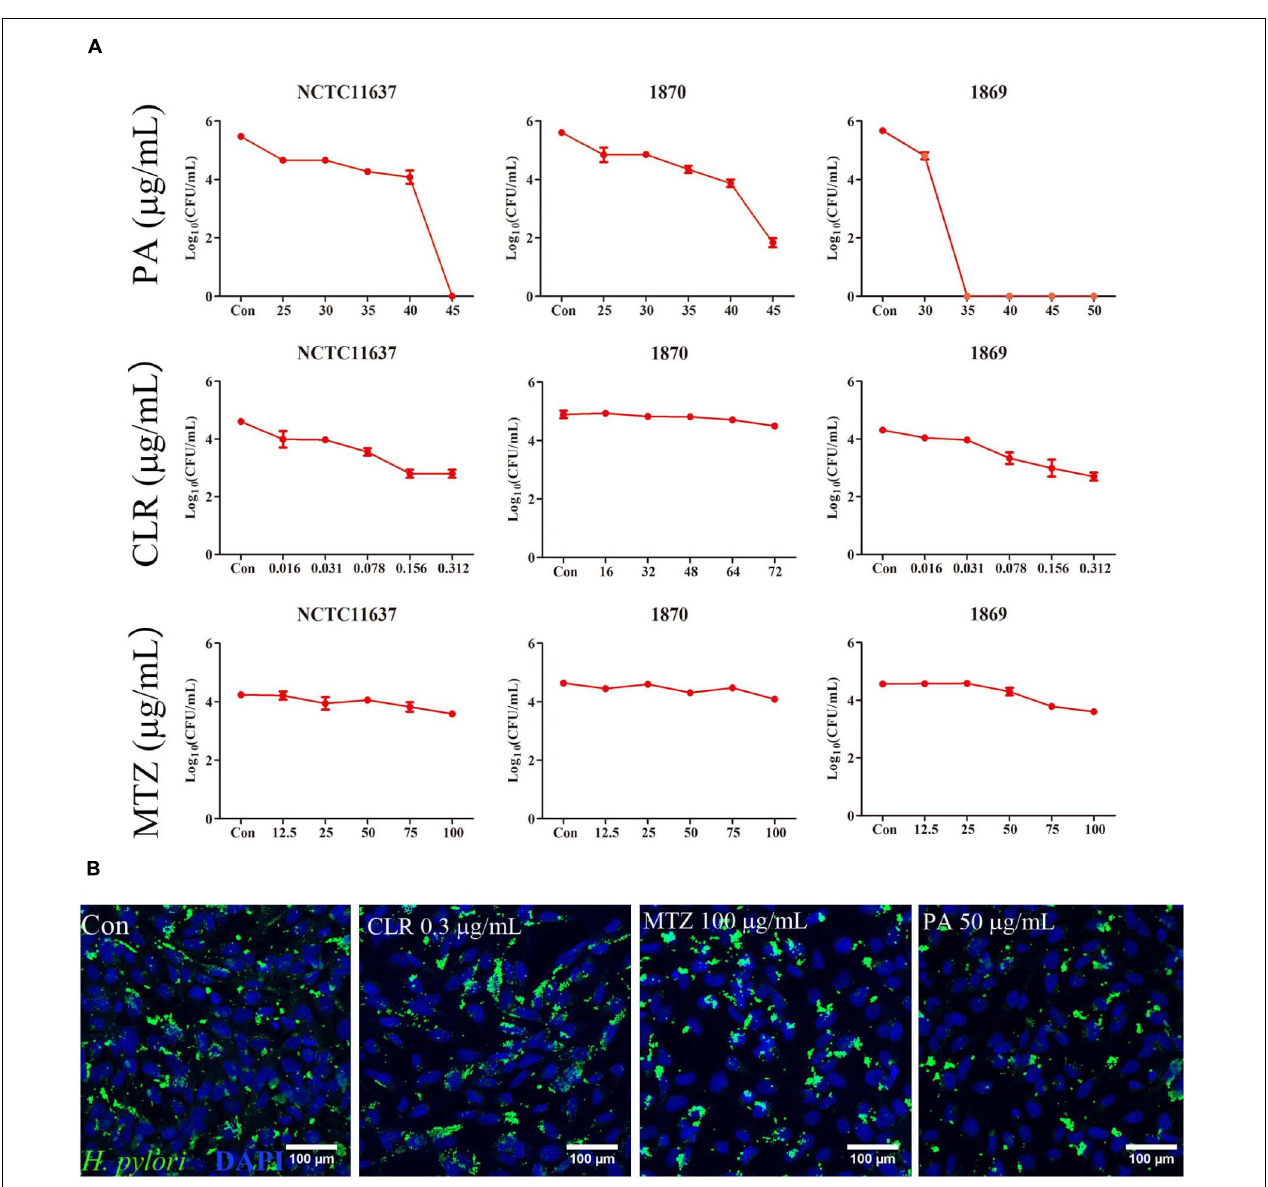
FIGURE 4 | Killing ability for intracellular H. pylori . (A) Intracellular H. pylori standard strain NCTC11637 and drug-resistant strains Hp1869 and Hp1870 were treated with different doses of PA, CLR, and MTZ, and the number of bacteria was presented as CFU/ml ( n = 3). Compared with the control group, a 99% decrease in the intracellular strain viability was defined as an effective extermination. (B) Representative confocal images by the immunofluorescence method to observe the ability of PA (2 MIC), CLR (20 MIC), and MTZ (25 MIC) to kill intracellular H. pylori NCTC11637; the bacteria were stained by anti- H. pylori antibody ab20459